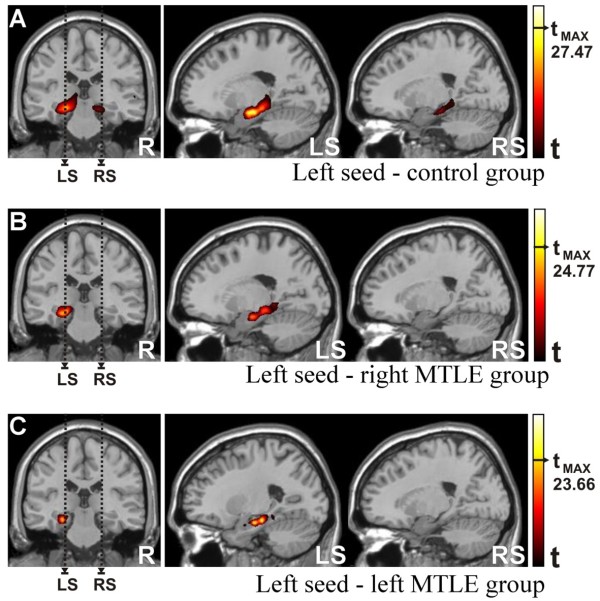
Functional Connectivity Maps (intragroup comparisons). Left seed: a) Control group: Major cluster parameters (LS): Tmax = 27.47 at (-21,-13,-21) MNI coord. and 9813 voxels. Minor cluster parameters (RS): Tmax = 21.61 at (24,-21,-19) MNI coord. and 5271 voxels. b) Right MTLE patient group: Major cluster parameters (LS): Tmax = 24.77 at (-24,-16,-22) MNI coord. and 3315 voxels. c) Left MTLE patient group: Major cluster parameters (LS): Tmax = 23.66 at (-26,-26,-23) MNI coord. and 1599 voxels. Abbreviations - LS: left sagittal image, RS: right sagittal image. Statistical maps with t-scores higher than 15.